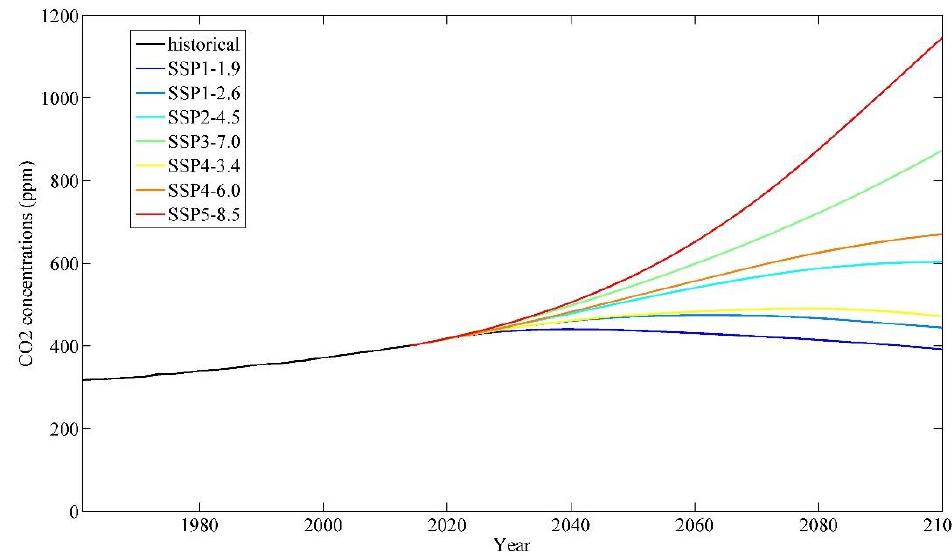
Figure 2. Changes in CO 2 concentration in China from 1961 to 2100.